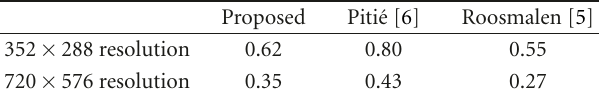
Table 3: Number of frames processed per second for the di ff erent compensation techniques.